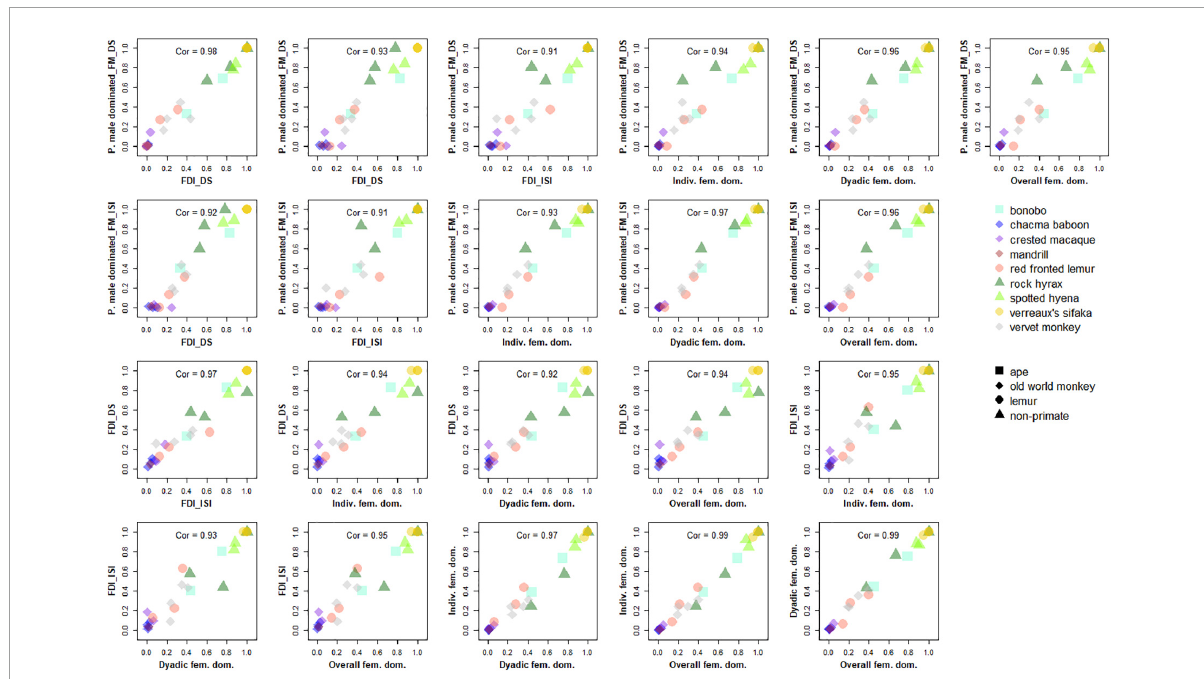
FIGURE1 Correlations among the five female dominance indices. All pairwise comparisons among the five indices are shown, with each point representing one social group of the nine species. The 7 indices are abbreviated on the axis as follow: P. male dominated._FM_DS: percentage of males dominated by each female in the hierarchy compiled using David’s score and based on heterosexual conflicts only ( Index 1a ) ; P. male dominated._FM_ISI: percentage of males dominated by each female in the hierarchy compiled using I&SI and based on heterosexual conflicts only ( Index 1b ) ; FDI_DS: female dominance index based on hierarchies compiled using David’s score and based on all conflicts ( Index 2a ) ; FDI_ISI: female dominance index based on hierarchies compiled using I&SI and based on all conflicts ( Index 2b ) ; Indiv. fem. dom.: Individual female dominance, percentage of intersexual conflicts won by females calculated for each female and averaged across all females ( Index 3 ) ; Dyadic fem. dom.: Dyadic female dominance, percentage of intersexual conflicts won by females in each male-female dyad and averaged across all heterosexual dyads ( Index 4 ) ; Overall fem. dom.: Individual female dominance, percentage of intersexual conflicts won by females over males overall across all heterosexual conflicts ( Index 5 ). “Cor”: correlation coefficient calculated using Spearman rank correlation tests.